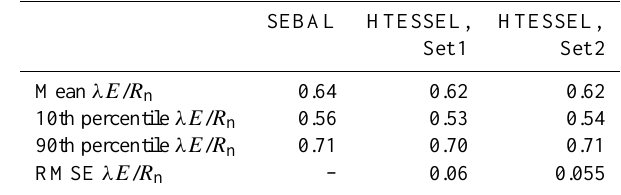
Table 1. Mean, minimum and maximum model grid values of initial soil water storage (mm) and initial water equivalent snow (mm) within the test region. Set 1 is the initial condition set that originates from the RACMO hindcast run, Set 2 is the equilibrium initial condition state.